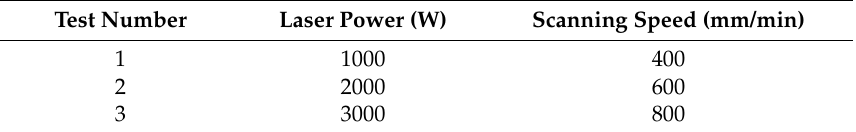
Table 2. Conditions of the tests to compare the theoretical with the experimental results.